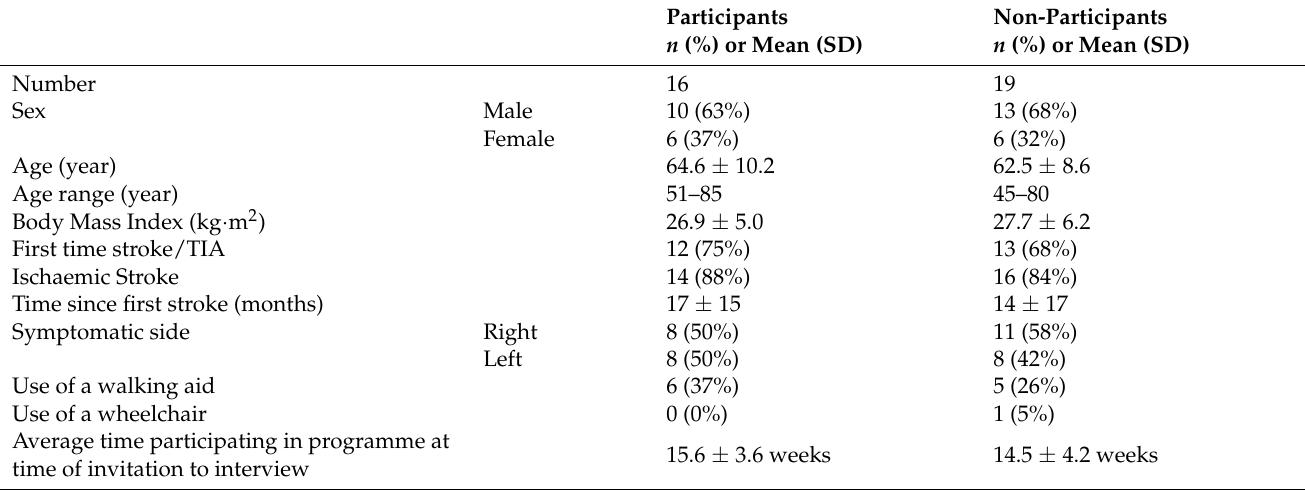
Table 1. Participant and non-participant